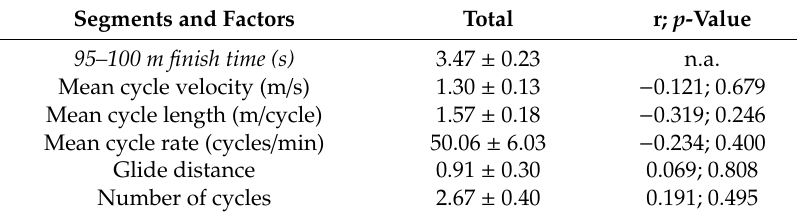
Table 7. Descriptive statistics (mean ± standard deviation) and partial correlation analysis of the finish segment time with underlying